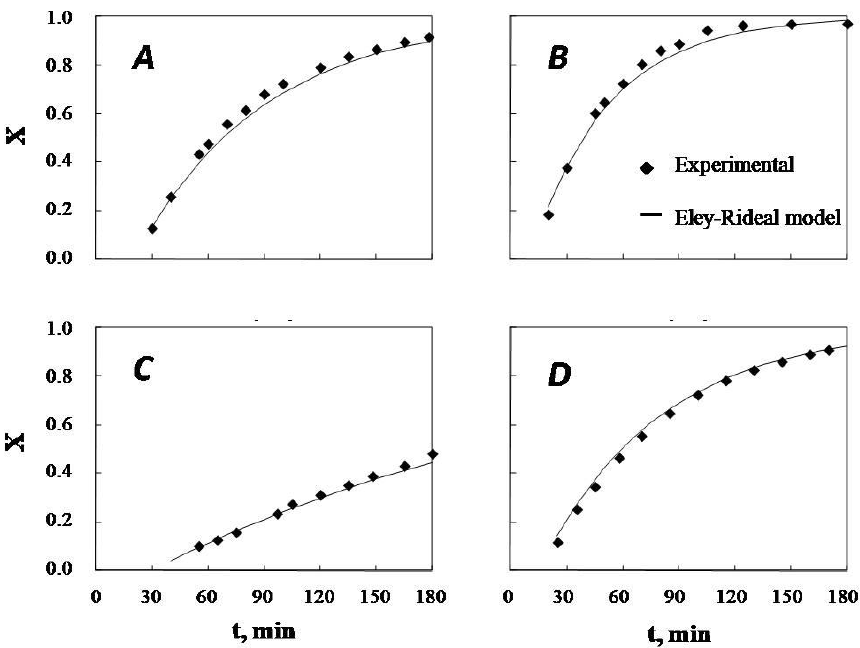
Figure 10. Conversion of FAMEs with reaction time: comparison between experimental and theoretical data (according to Eley-Rideal method). Chemical conditions for each experiment: ( A ) catalyst amount, 3% w / w ; methanol/oil ratio, 9:1; stirring rate, 700 rpm; temperature, 65 °C; ( B ) catalyst amount, 5% w / w ; methanol/oil ratio, 9:1; stirring rate, 700 rpm; temperature, 65 °C; ( C ) catalyst amount, 5% w / w ; methanol/oil ratio, 9:1; stirring rate, 700 rpm; temperature, 45 °C; ( D ) catalyst amount, 5% w / w ; methanol/oil ratio, 9:1; stirring rate, 700 rpm; temperature, 60 °C.